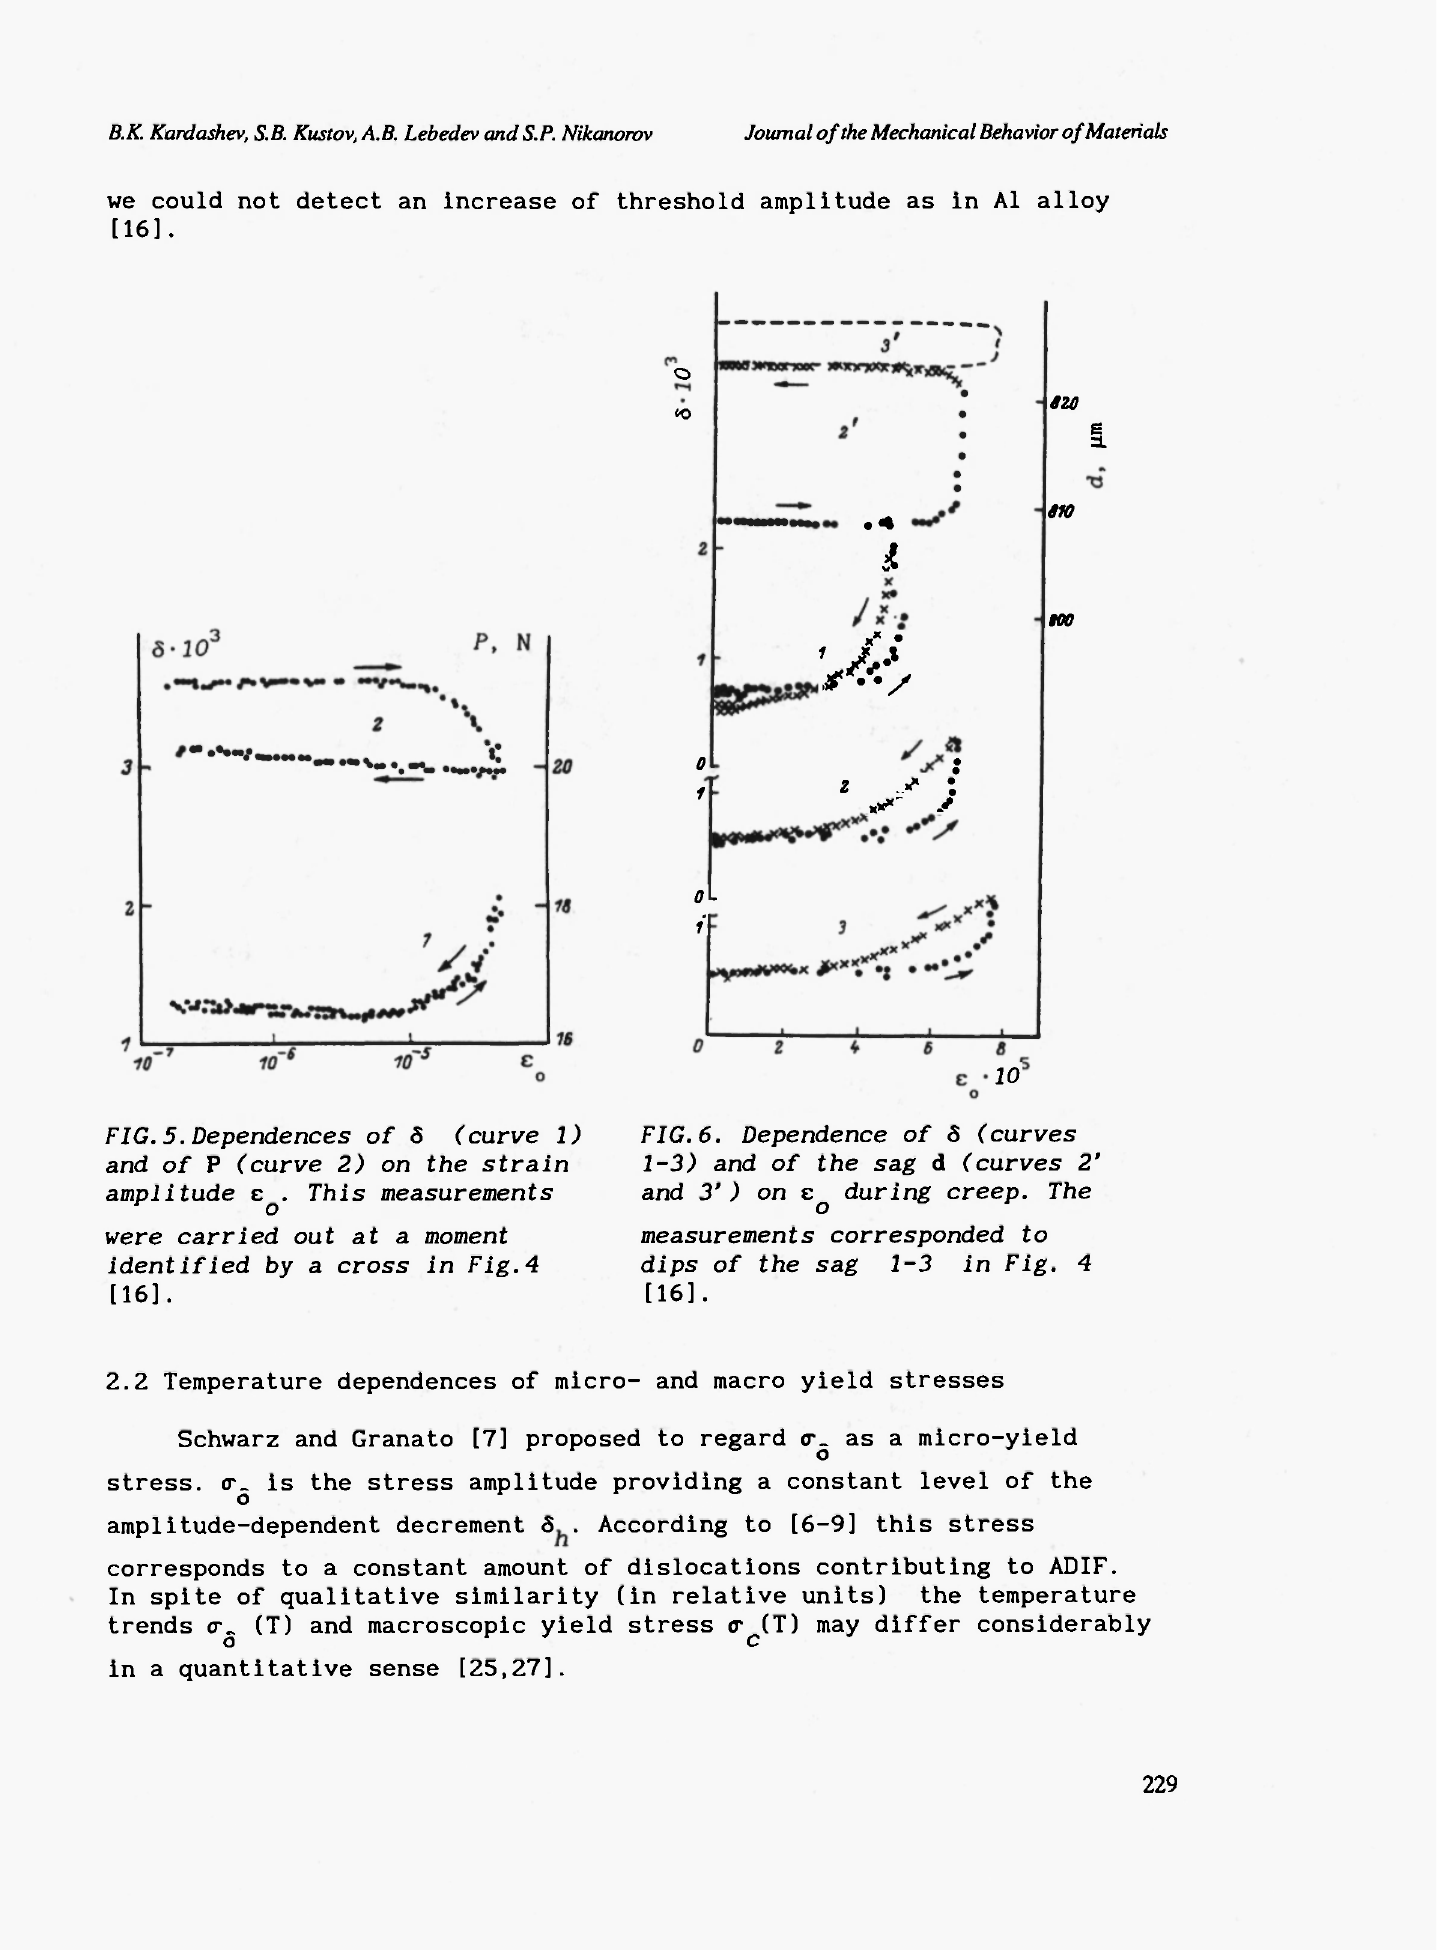
FIG.5.Dependences of δ (curve 1) and of Ρ (curve 2) on the strain amplitude ε . This measurements ο were carried out at a moment identified by a cross in Fig.4 [16].